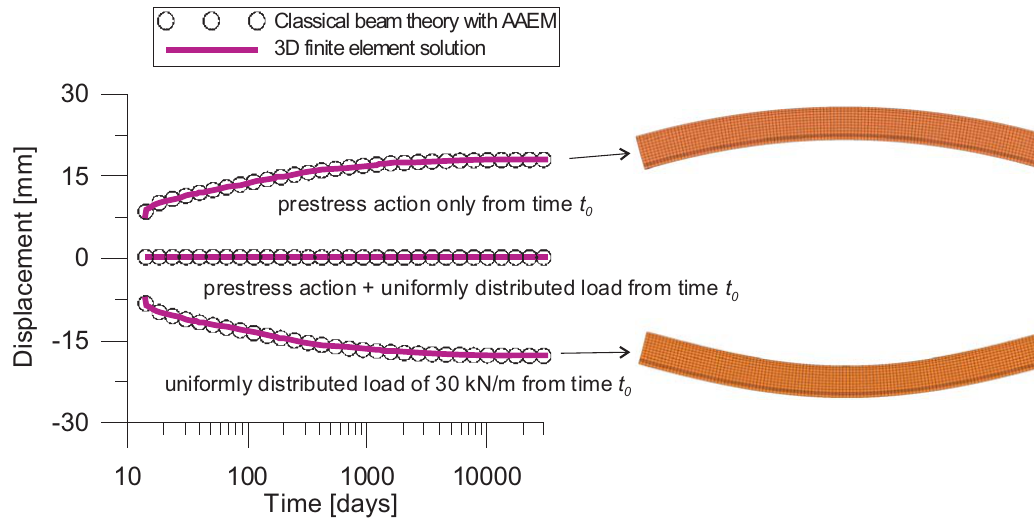
Figure 4. Simply supported prestressed concrete beam: ( a ) Cross-section geometry in millimeters; ( b ) boundary conditions and loading; ( c ) load history; ( d , e ) finite element mesh.